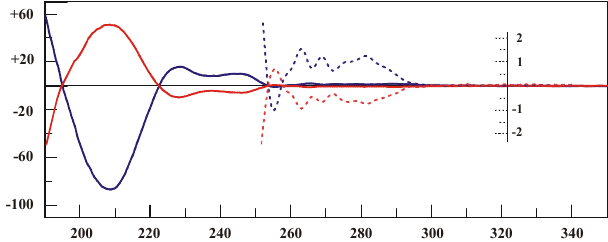
Figure 3. X ‐ ray structure (S) ‐ ( ‐ ) ‐ BIClPO (water molecule and hydrogen atoms were omitted for clar ‐ Figure 3. X-ray structure (S)-(-)- BIClPO (water molecule and hydrogen atoms were omitted for ity) and the CD spectra of its enantiomers: (S) ‐ ( ‐ ) ‐ BIClPO (>99% ee, blue), (R) ‐ (+) ‐ BIClPO (60 % ee, clarity) and the CD spectra of its enantiomers: (S)-(-)- BIClPO (>99% ee, blue), (R) -(+)- BIClPO red) recorded in CH 3 CN. (60% ee, red) recorded in CH 3